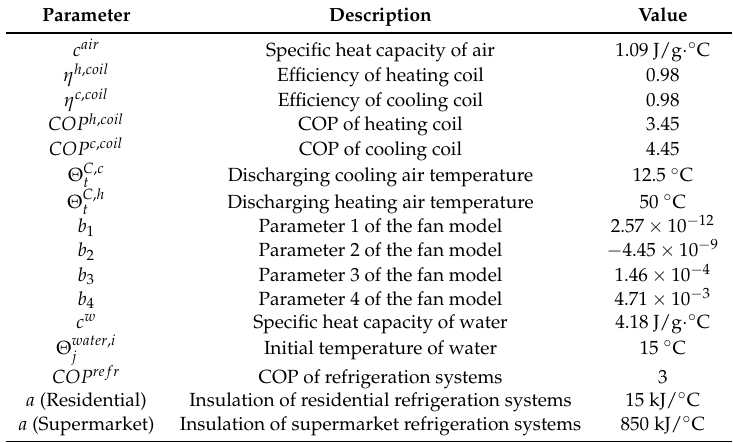
Table A1. Summary of the parameters used in the models presented in Section 3.4.